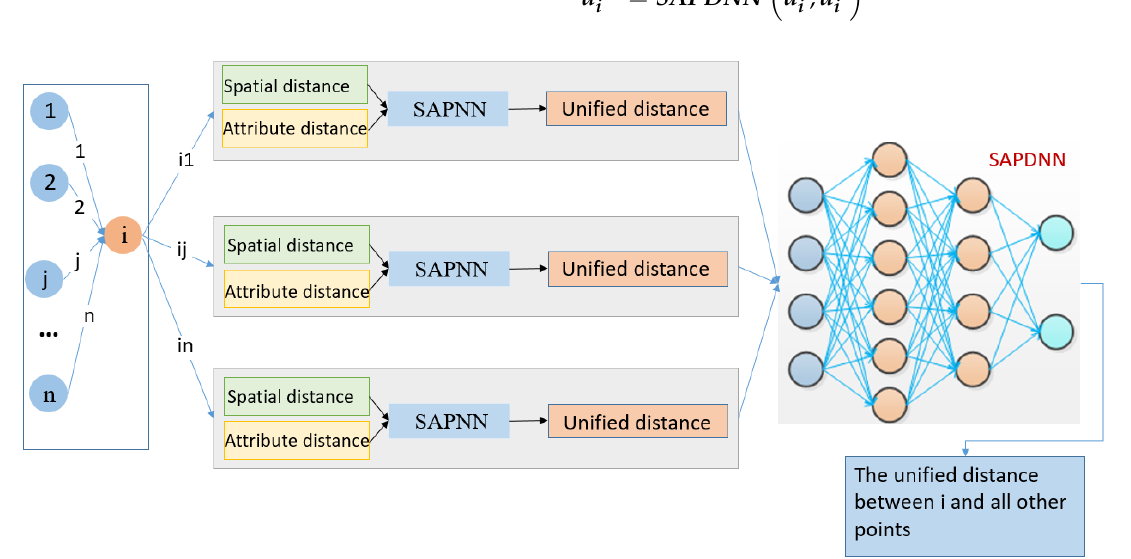
Figure 3. The structure of SAPDNN.